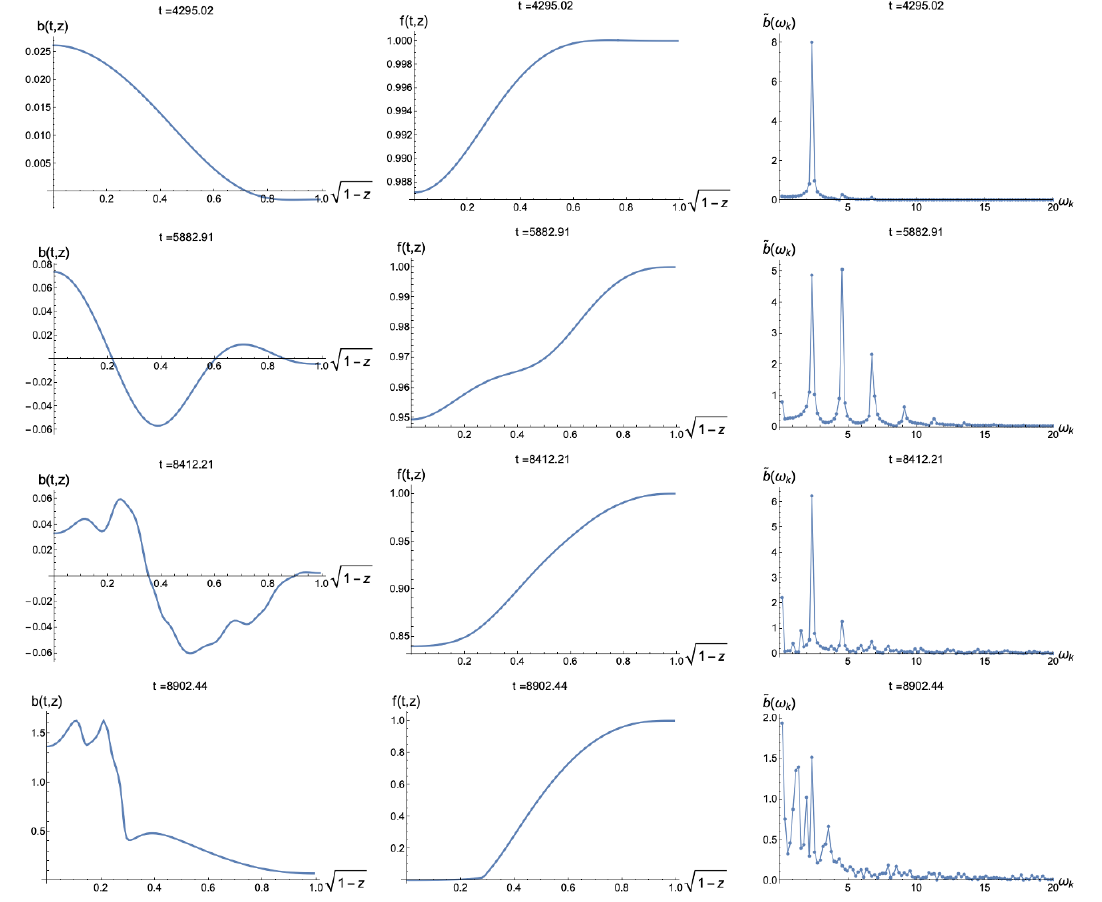
Figure 9 . Four snapshost of the build-up protocol of (cid:12)gure 7 corresponding to ! = 2 : 375 (see p green dots in (cid:12)gure 6). The abscisa has been taken to be z 0 (cid:0) z with z 0 = 1 in order for the pro(cid:12)les to range from the tip (on the left, z = 1) to the asymptotic boundary (on the right, z = 0). The Fourier transform of b ( t; z 0 ) at the tip, over a time span of (cid:1) t = 400, is shown on the right. The resonant coupling to the higher normal modes is apparent at t = 8412 . For higher driving amplitudes a cascade towards higher frequencies is behind a wiggly, yet regular, pro(cid:12)le for b ( t; z ). Finally, the apparent horizon starts forming near z = 0 : 3 as seen in the last plot of f ( t; z